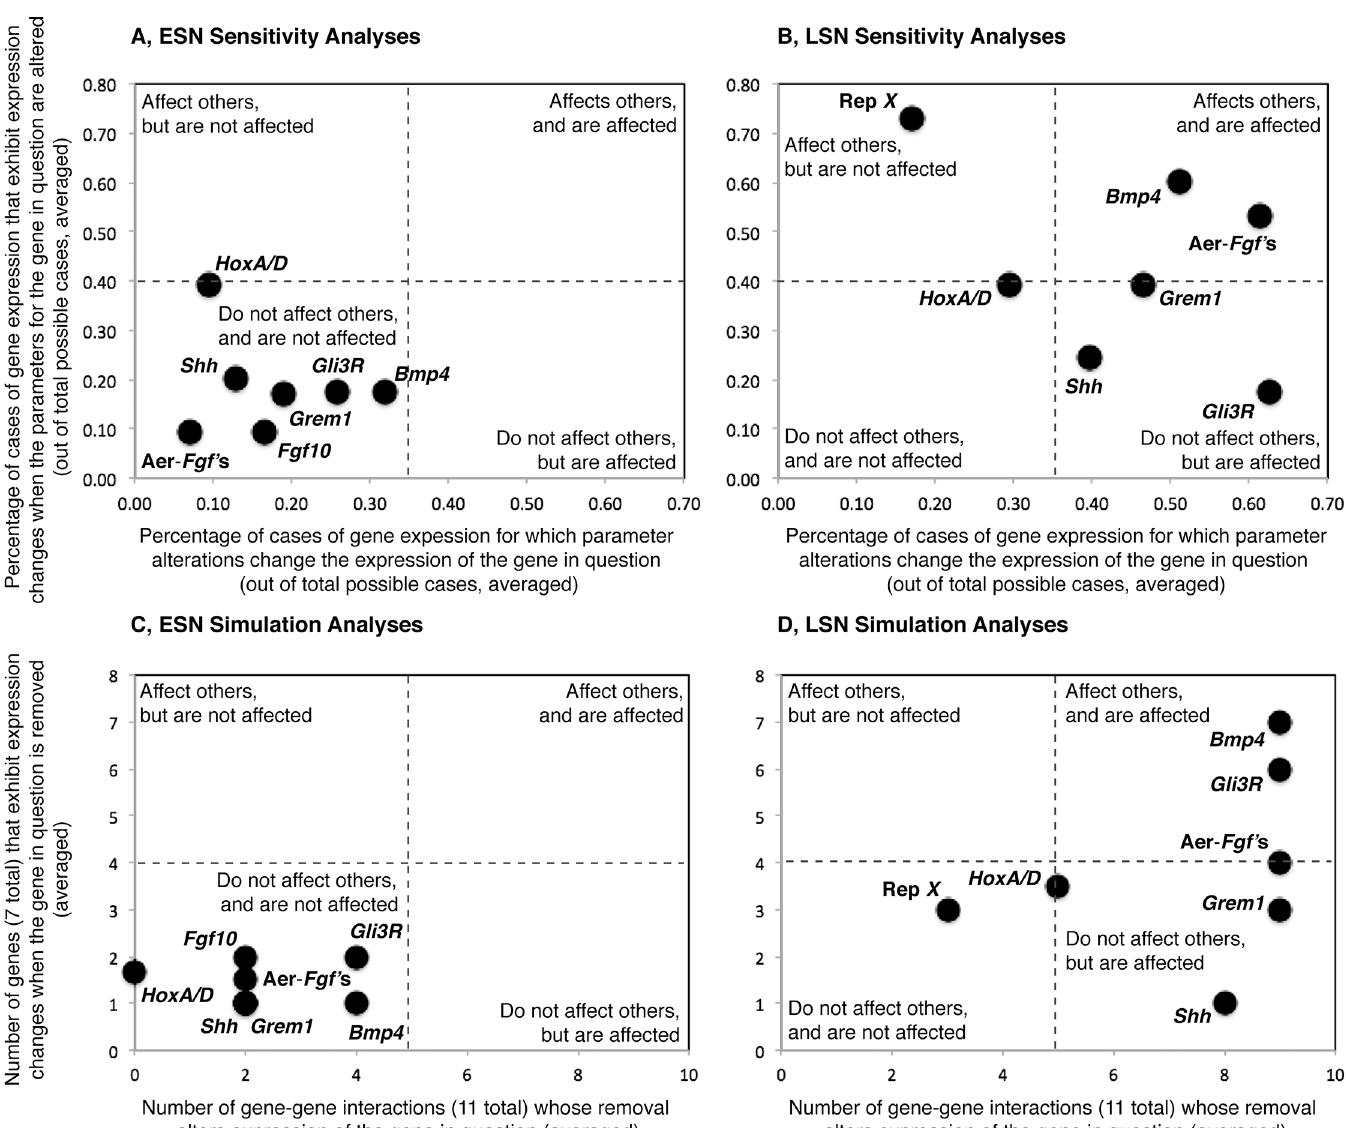
Fig 2. Visualizations of the results of the sensitivity and simulation analyses, all plots are shown at the same scale. The ability of alterations in gene- related parameter values (e.g., p b , K 10 , a b for ESN Bmp4 ) to impact gene expression levels (Y-axes) and the sensitivity of gene expression levels to parameter value alterations (X-axes) are shown for the Early (A) and Late (B) stage networks. The ability of individual genes to impact the expression levels of other genes when removed (Y-axes) and the sensitivity of the expression levels of individual genes to the removal of other genes (X-axes) are also shown for the Early (C) and Late (D) stage networks. Both sensitivity (A) and simulation (C) analyses suggest that perturbations in the ESN tend not to have a great effect on gene expression levels, and ESN gene expression levels tend not to be greatly affected by perturbations. Sensitivity (B) and simulation (D) analyses also suggest that perturbations in the LSN have a greater ability to disrupt gene expression values and the expression levels of LSN genes are more sensitive to perturbations than are those of ESN